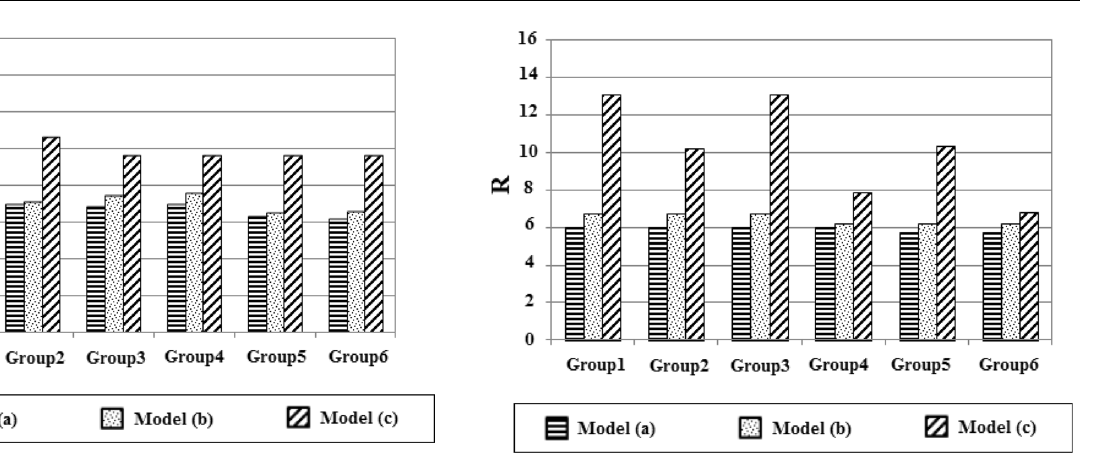
Fig. 18 Comparison of the response modification factors of the studied models of the 8-story 3-span structure